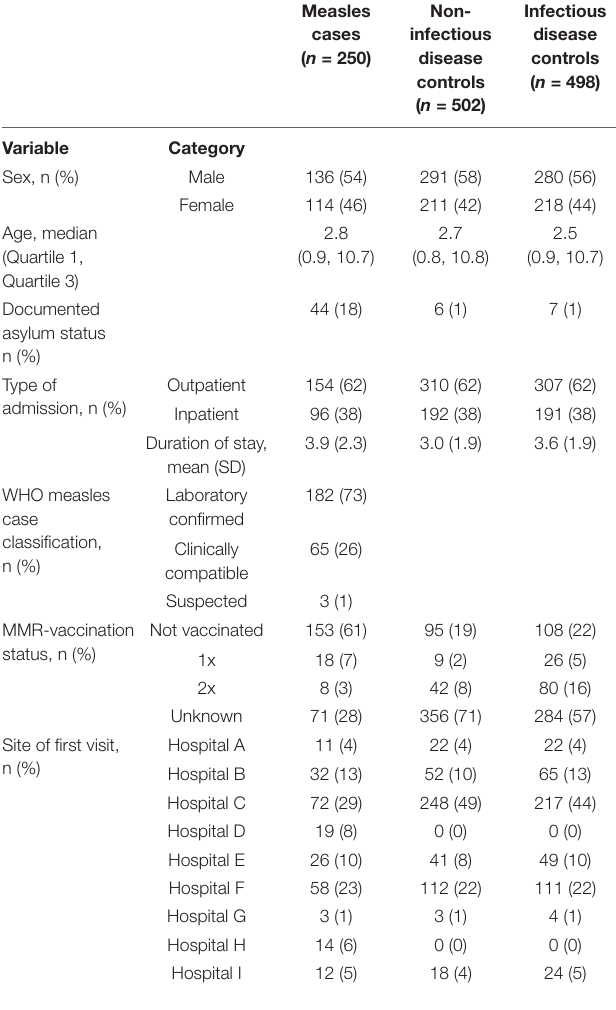
TABLE 1 | Baseline characteristics.